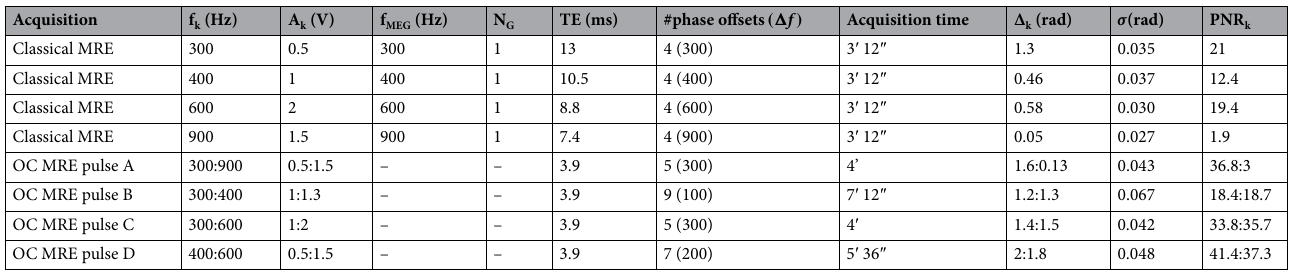
Table 1. Acquisition parameters (frequencies f k and amplitudes A k of the excitation shear wave; frequency f MEG and number of cycles N G of the MEG; echo time, number of phase offsets, frequency resolution of the sampling (cid:31) f and acquisition time) and results (phase encoding Δ, phase error σ and PNRs) obtained with the different acquisition